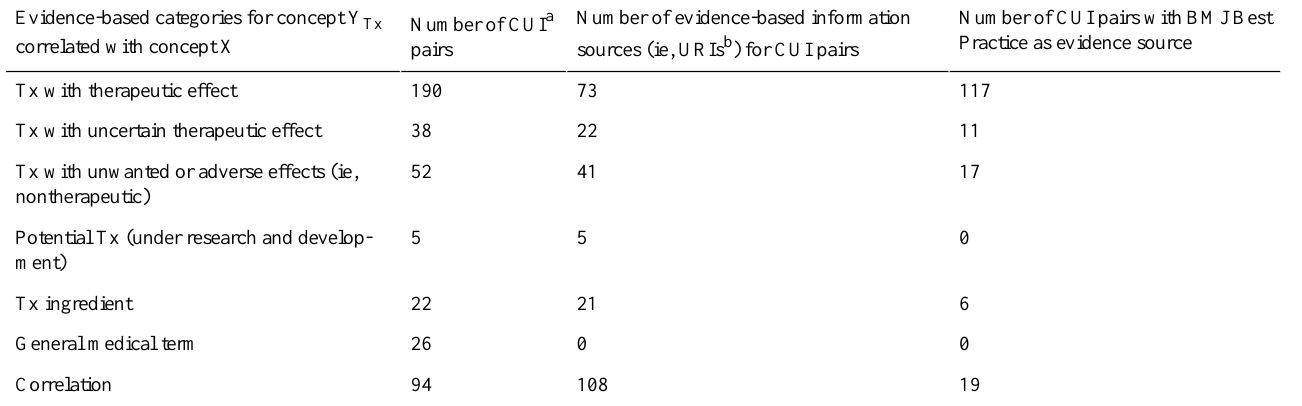
Table 3. The 408 unified medical language system concept unique identifier pairs investigated thoroughly and their evidence-based information sources per evidence-based